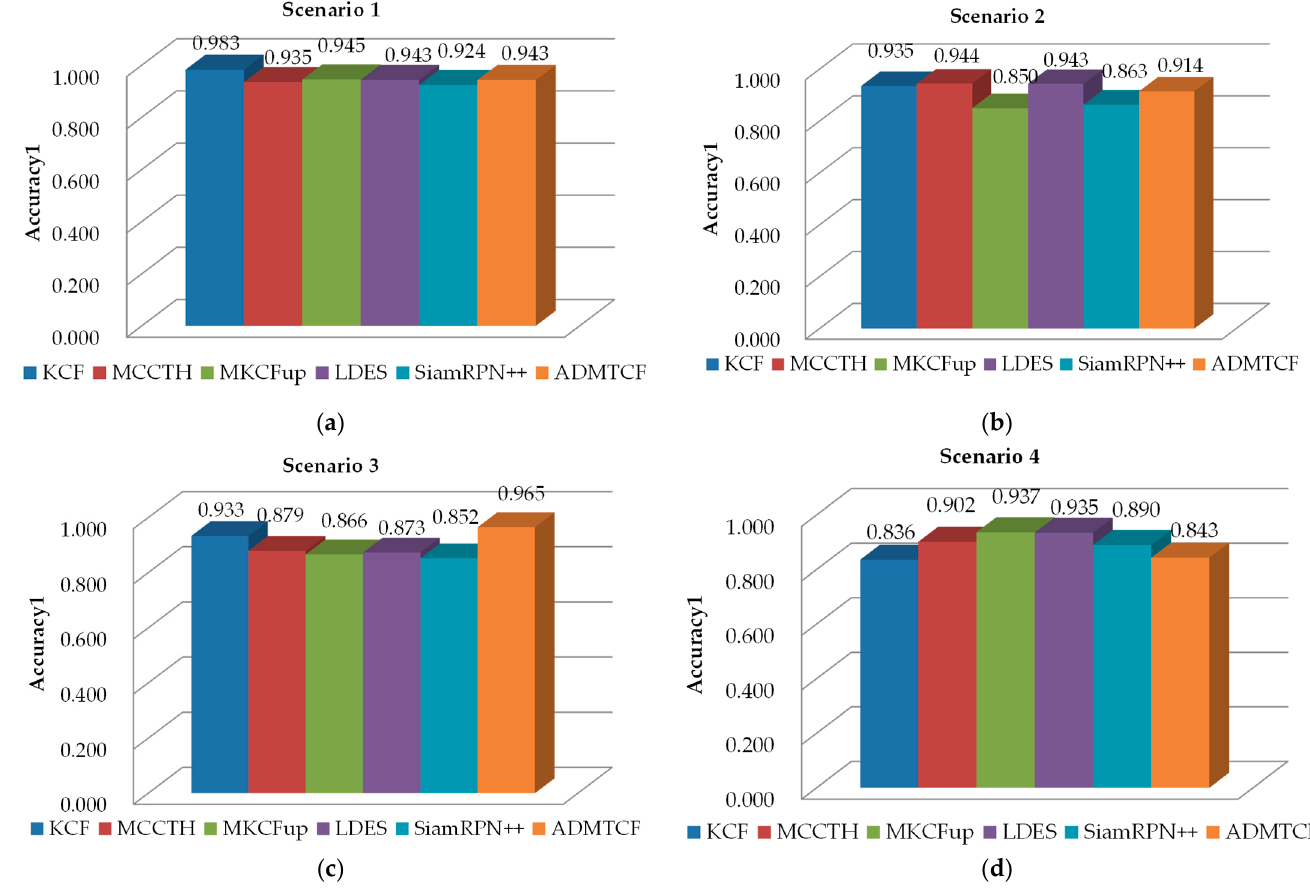
Figure 13. Tracking accuracy using Metrics-1: ( a ) scenario 1; ( b ) scenario 2; ( c ) scenario 3; ( d ) scenario 4.